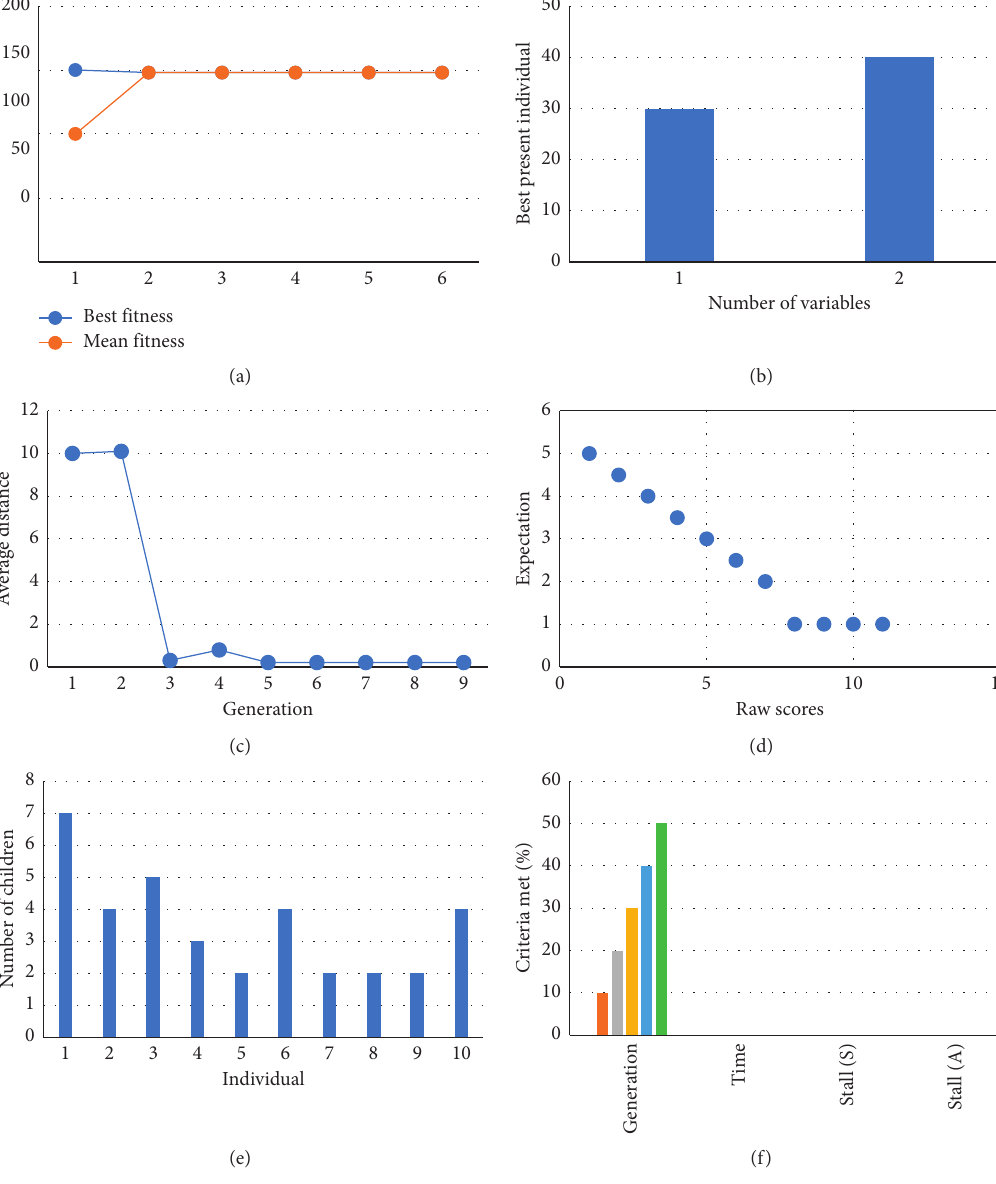
Figure 14: GA optimization method. (a) Best and mean fitness. (b) Present best individual. (c) Average distance between individuals. (d) Scaling fitness. (e) Selection function. (f) Stopping